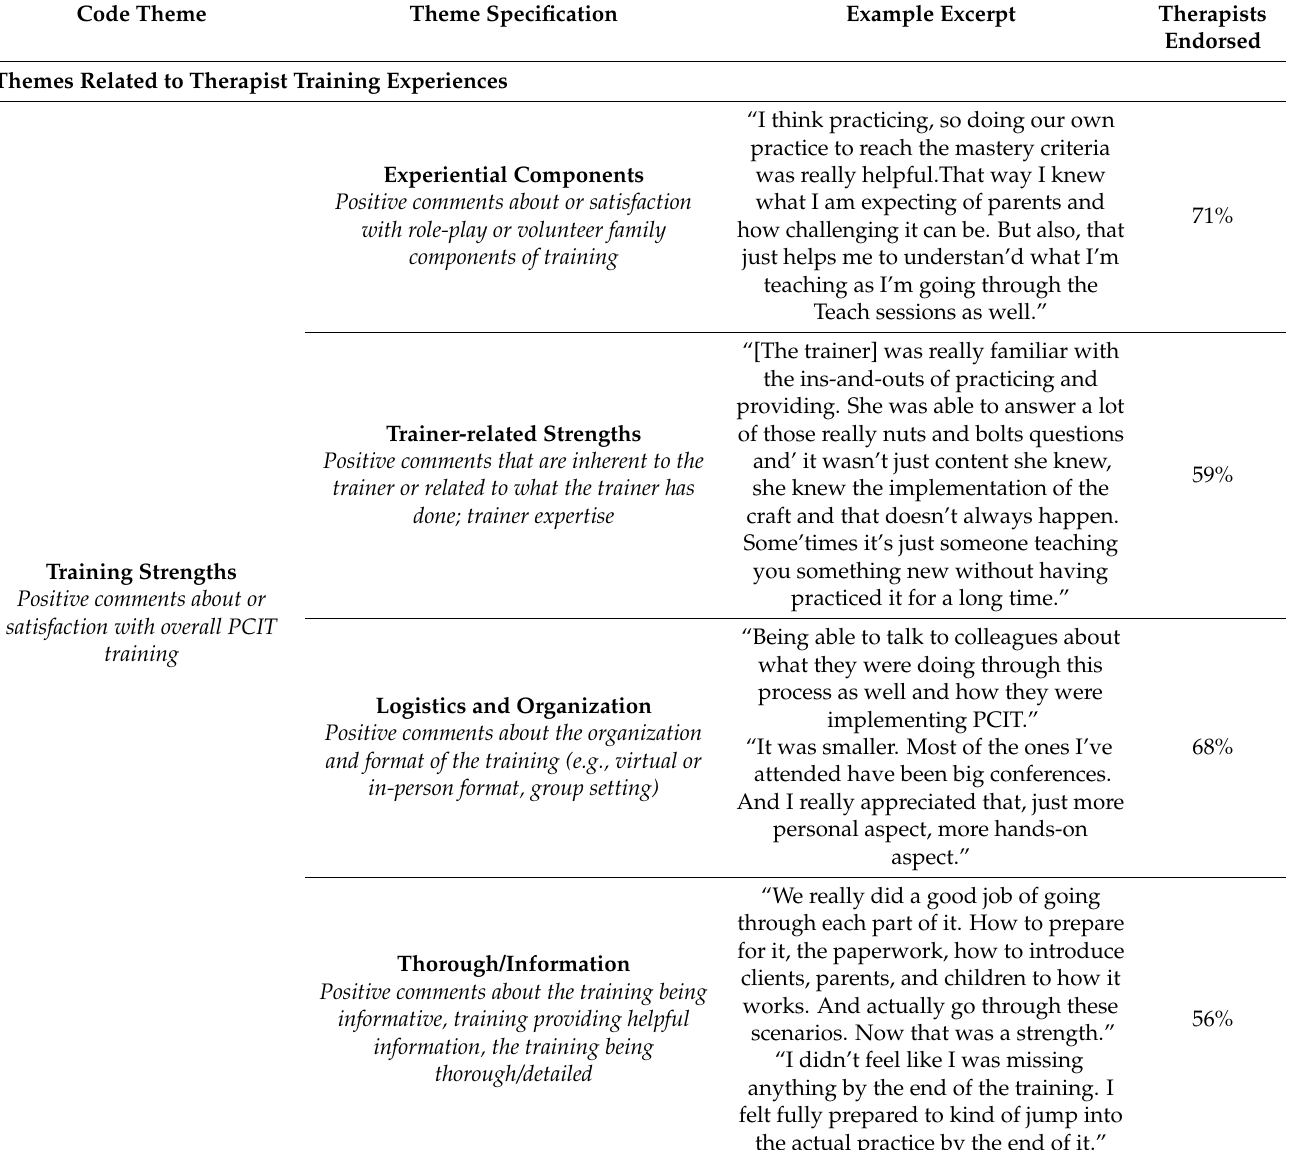
Table 2. Qualitative Themes Endorsed by Therapists ( n =